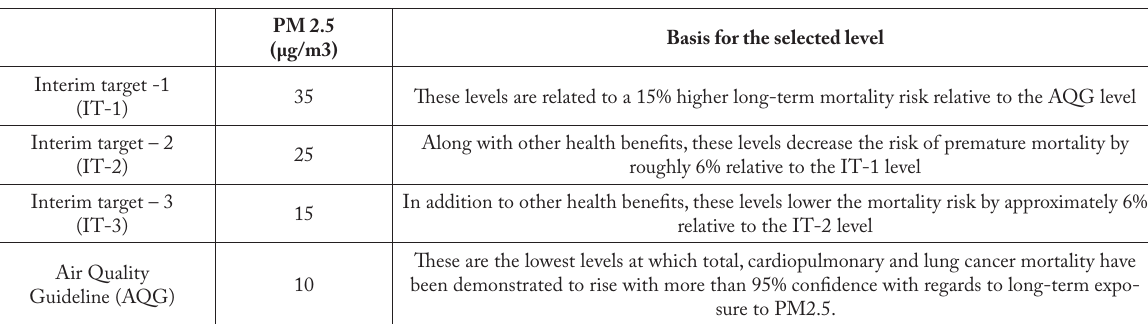
Table 3. WHO air quality guidelines and interim targets for particulate matter: 24-hour concentrations for manage- ment purposes (Source: World Health Organization, 2016).